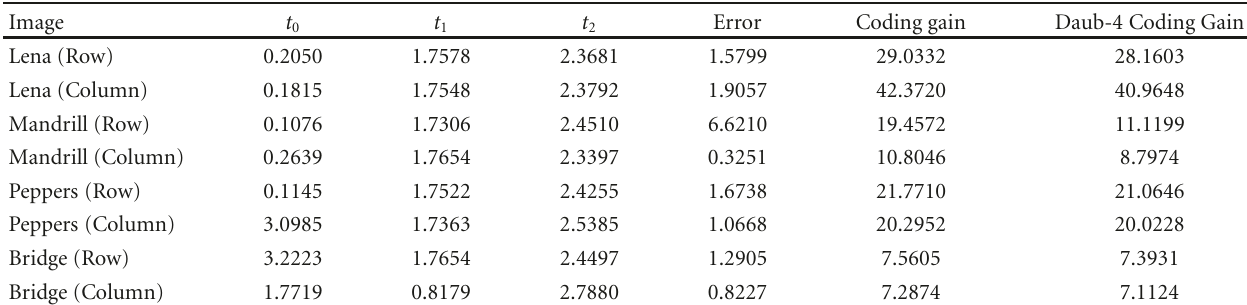
Table 7: Lattice parameters obtained by BWT inversion, squared errors, coding gains, and Daub-4 coding gains for the test